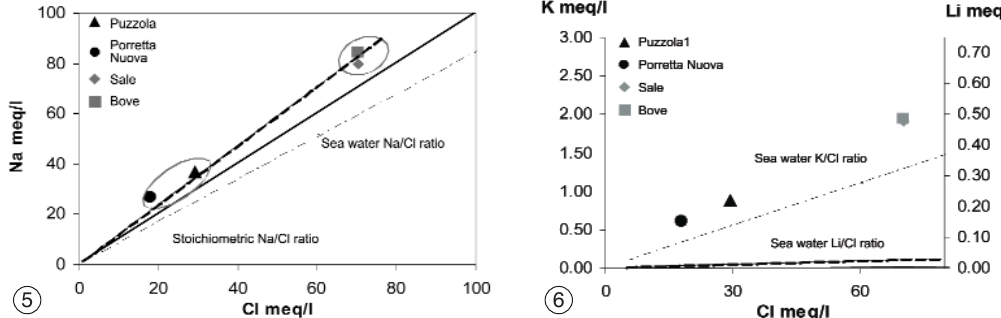
Fig. 5. meq/l Na versus meq/l Cl diagram. The figure distinguishes two water groups: Puzzola 1 and Porretta Nuova, marked by lower salinity and Bove and Sale springs characterized by higher concentrations. The Porret- ta Nuova and Puzzola1 samples represent the more diluted terms of a hypothetical mixing between a meteoric and a groundwater terms (dashed line) in the Porretta thermal system. All the samples are Na-enriched with re- spect to the stochiometric Na/Cl ratio and the Na/Cl ratio of seawater (black and dash-dot line respectively). Fig. 6. meq/l K versus meq/l Cl and meq/l Li versus meq/l Cl concentration at the Porretta terme springs show- ing the enrichment in alkaline elements with respect to sea